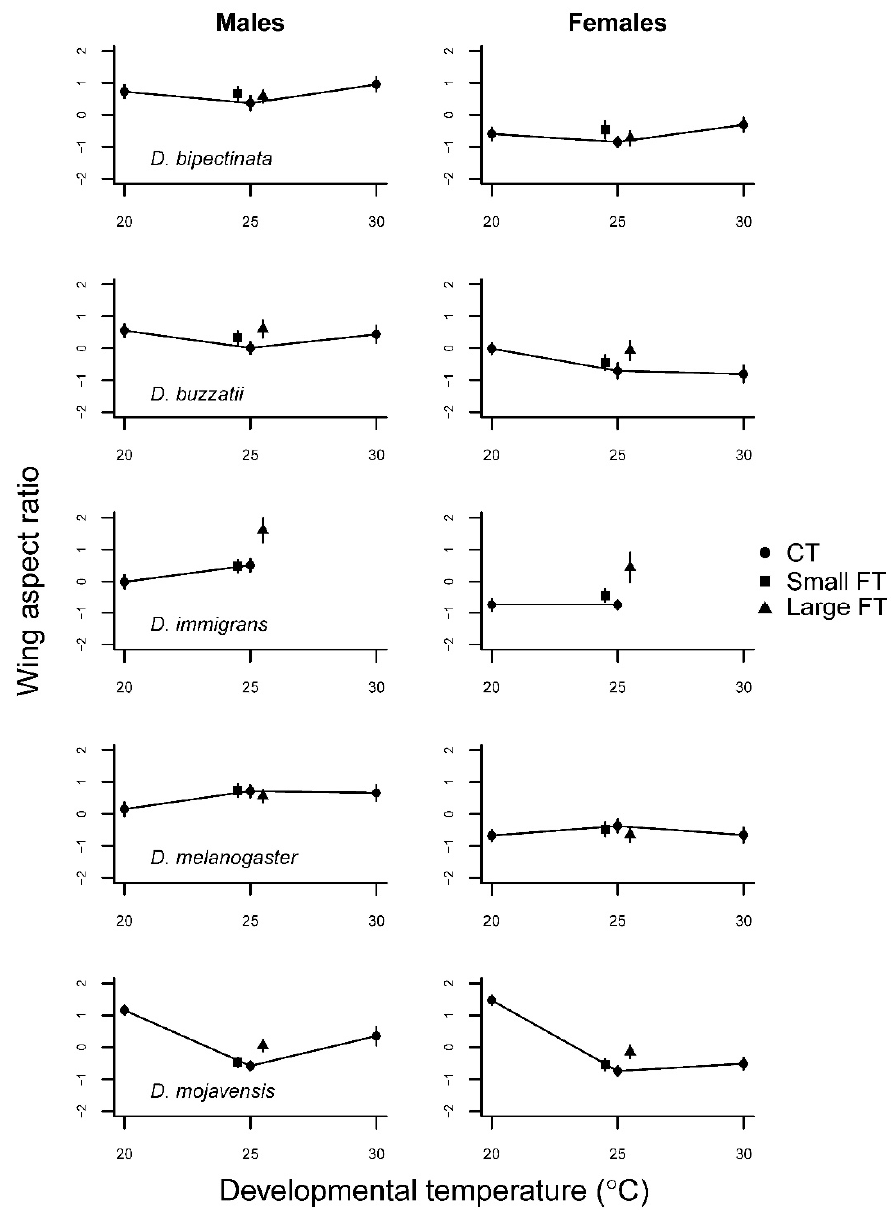
Figure 4. Wing aspect ratio (wing width divided by wing length) as a function of developmental temperature regimes in five Drosophila species with 95% confidence intervals. Table 2. Effects of temperature and sex on wing size and wing aspect ratio within species. Separate tests were conducted for the constant (20, 25, and 30 °C) and fluctuating temperature (25 °C CT, small and large amplitude FT) comparisons.